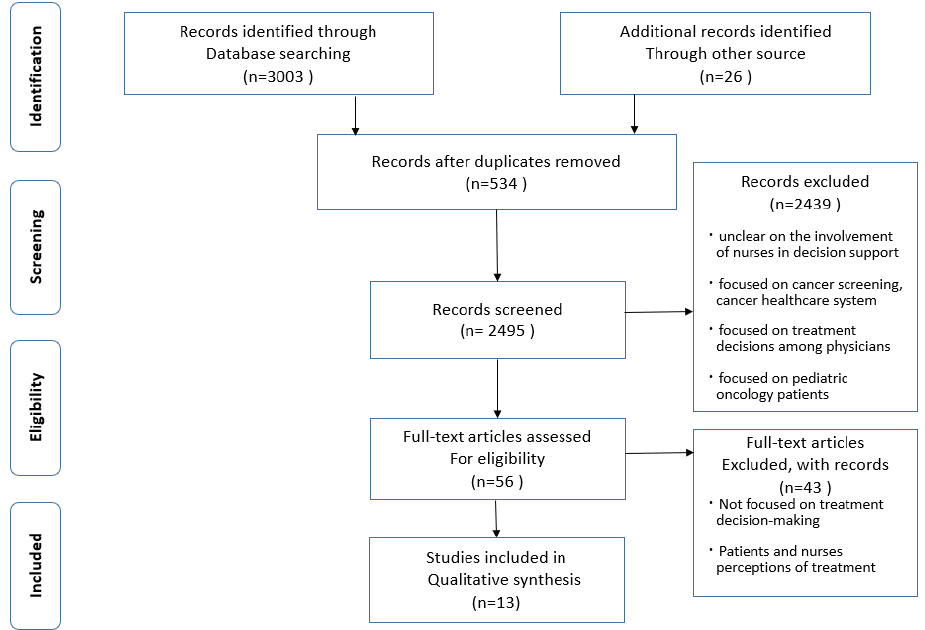
Figure 1. PRISMA flow diagram.